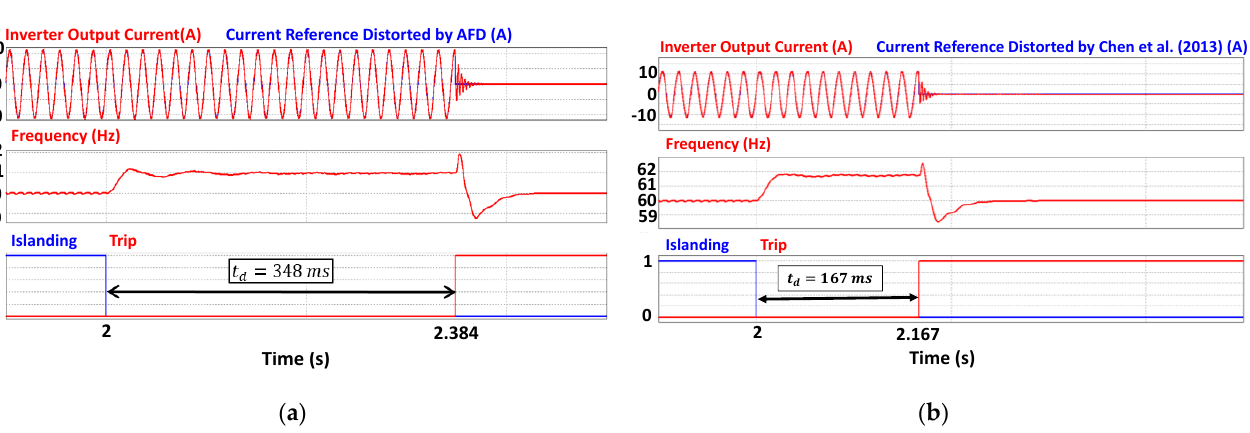
Figure 16. Current, frequency, “Islanding”, and “Trip computational results for C norm = 1 ( a ) under AFD implementation; ( b ) under AFD by Chen et al. (2013) [24] implementation.